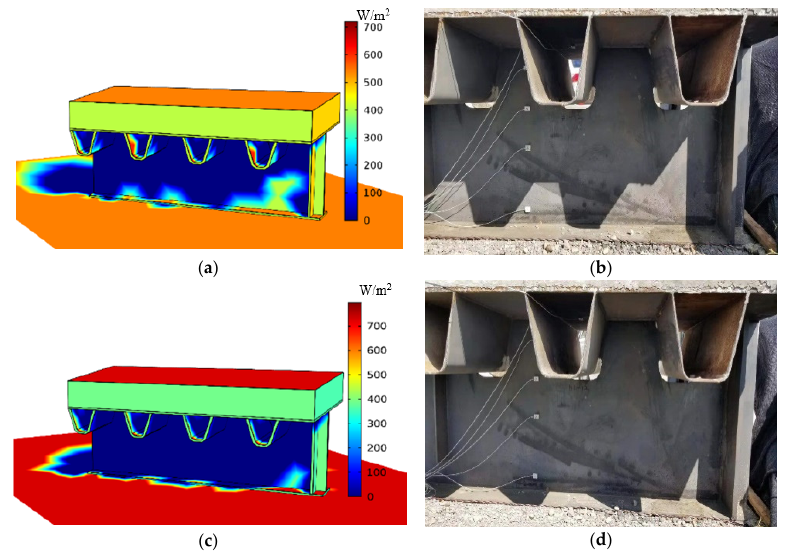
Figure 13. Simulation results of the solar radiation absorbed by surfaces at different times. ( a ) Simulation of the absorbed radiation at 8:00; ( b ) Shading zone at 8:00; ( c ) Simulation of the absorbed radiation at 10:00; ( d ) Shading zone at 10:00.